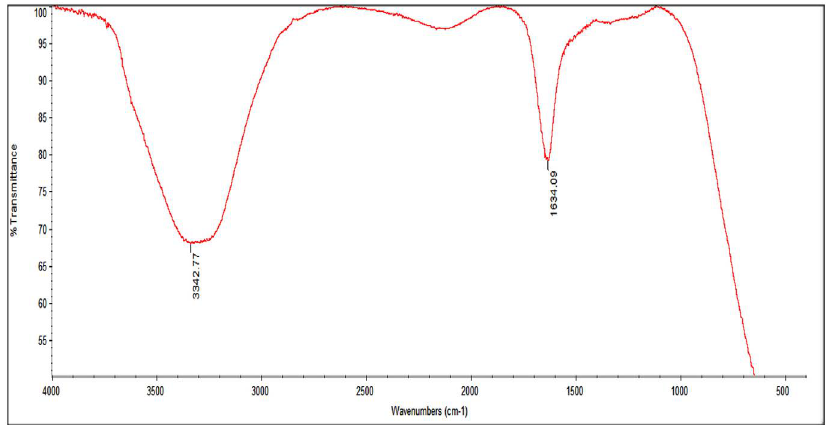
Fig. 2. FTIR spectra of AgNPs